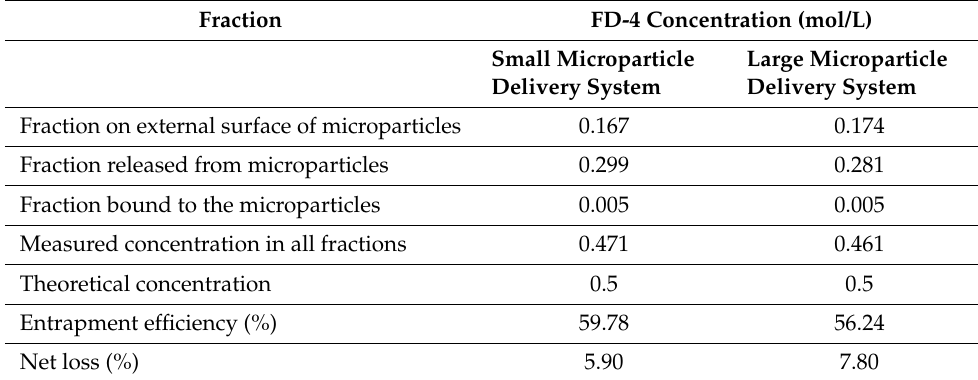
Table 3. FD-4 content in different fractions of the microparticle delivery systems.